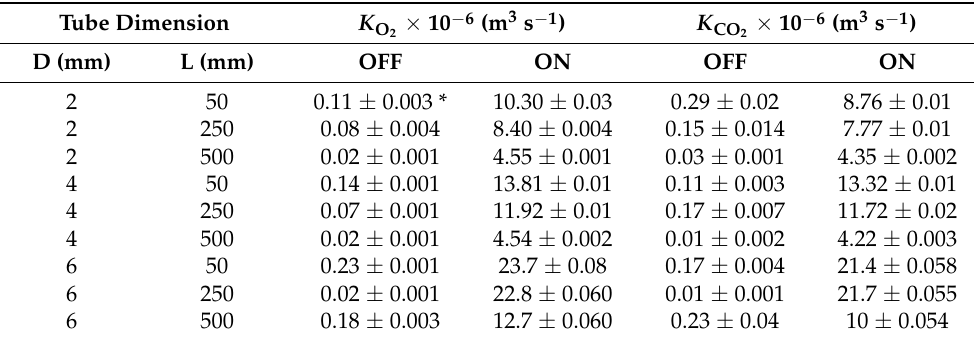
Table 2. Mass transfer coefficients ( K O (diffusion) for tubes of different